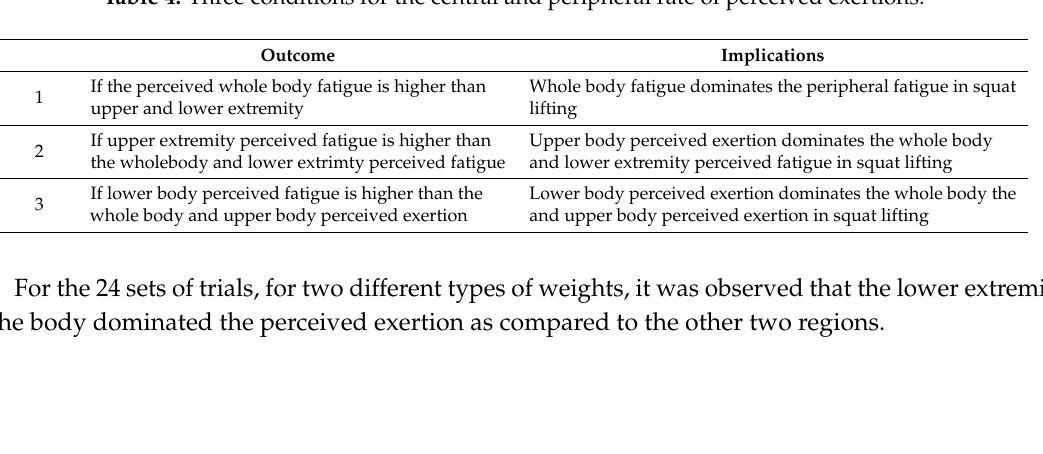
Table 4. Three conditions for the central and peripheral rate of perceived